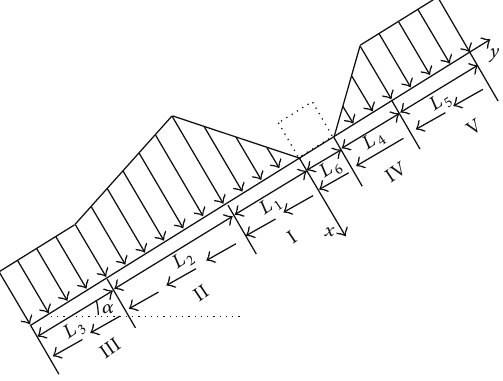
Figure 5: Mechanical model of floor under